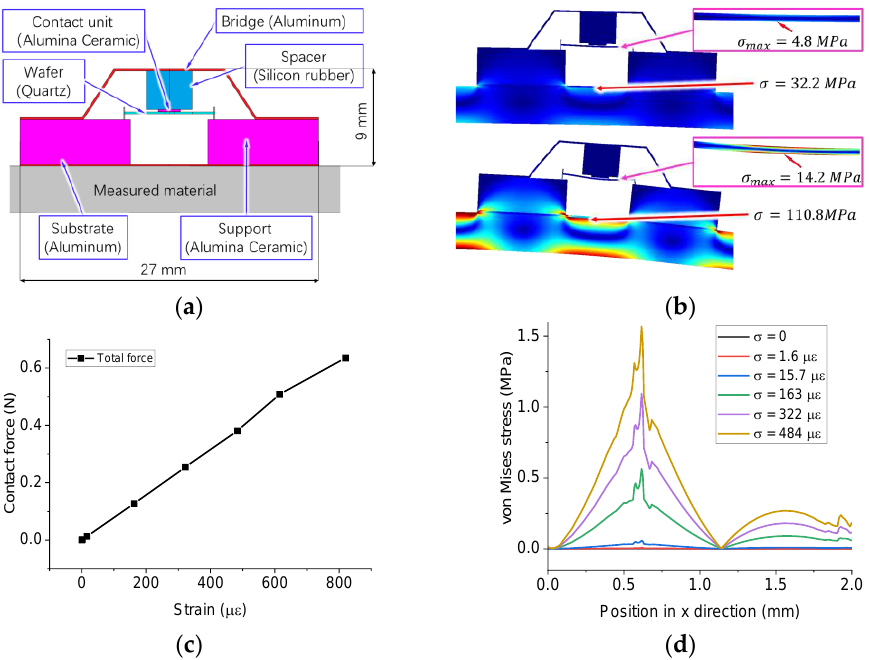
Figure 5. The numerical model of the sensing housing. ( a ) The design of the sensor. ( b ) The deformation and stress distribution of the sensor when the beam is bent into different shapes. The strain of the measured surface is 163 με and 484 με in the upper and lower case, respectively. ( c ) The total contact force as a function of the strain. ( d ) The von Mises stress distribution along the contact unit.